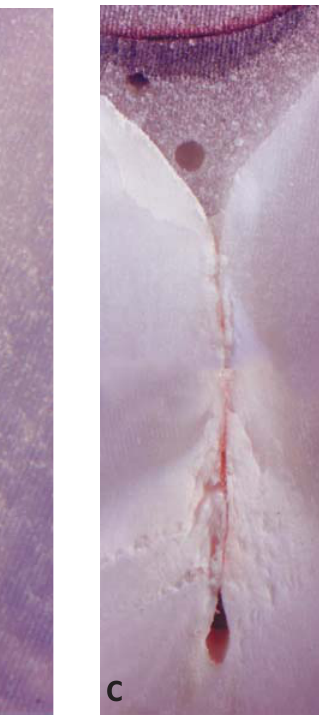
FIGURE 3 - Tooth seccions displaying fissures sealed with:- (A) Fuji Plus – score 0 for (MM) and score 3 for (DP), (B) Ketac- Molar – score 0 for (MM) and score 3 for (DP); (C) Vitremer dilueted at ¼ - score 0 for (MM) and score 3 for